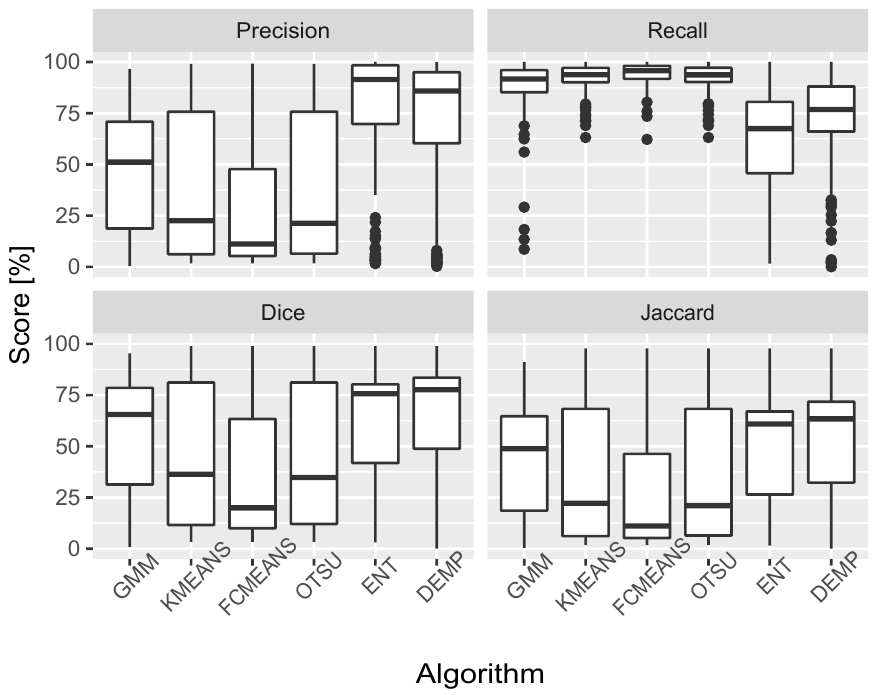
Figure 5. Boxplots of the metric distribution using different clustering algorithms for the crack image segmentation